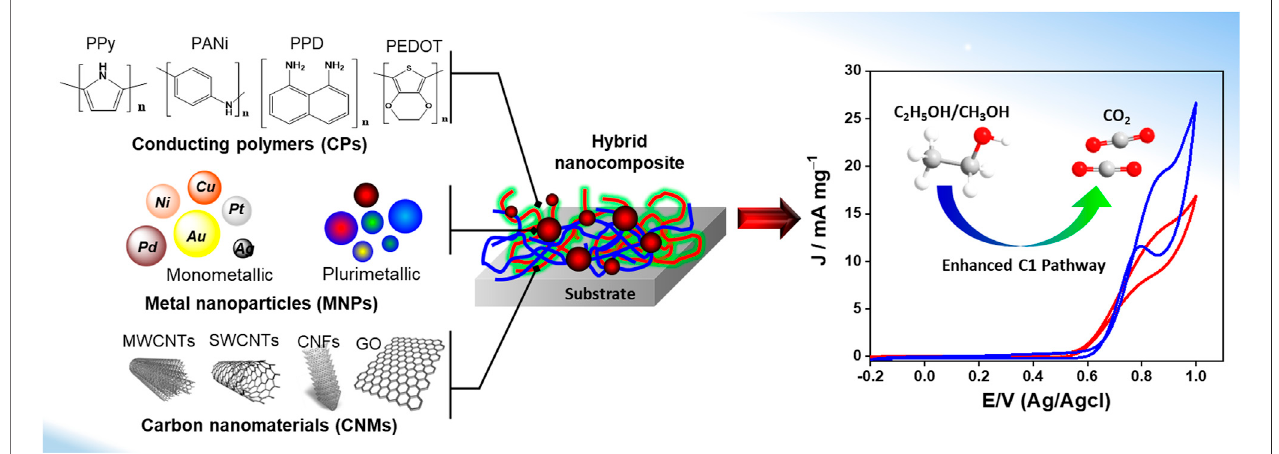
FIGURE 5 | Conducting Polymers/ Carbon nanomaterials/ Metal nanoparticles as anode catalysts for alcohol oxidation.